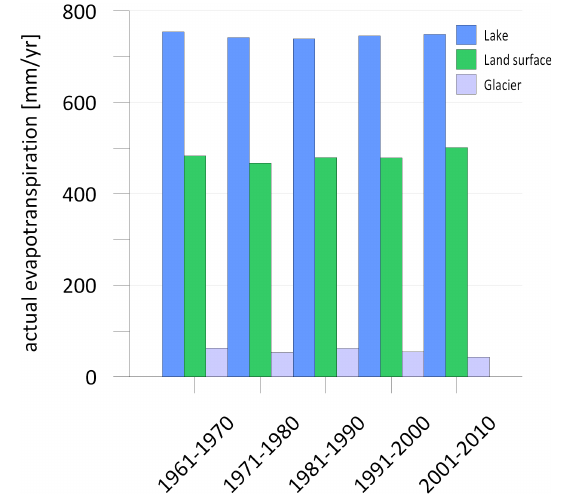
Fig. 4. Actual evaporation rates for the five simulated decades and the three different land cover